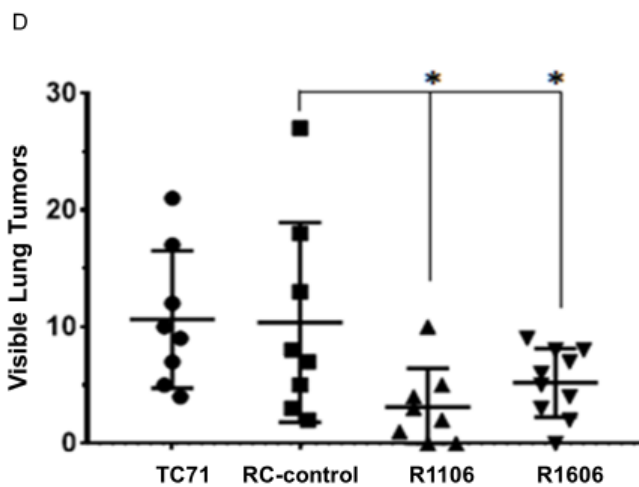
Figure 2. Down ‐ regulation of REST inhibited tumor growth. ( A ) Totals of 5 × 10 5 TC71 parental, RC ‐ control, R1106, or R1606 cells were injected into the tibias of nude mice (10 mice per group). Tumor size was measured 4 weeks later, and the average tumor volume was calculated. One ‐ way analysis of variance (ANOVA) showed a significant difference in tumor volume among groups ( p = 0.001) or between groups (* p < 0.05). ( B ) Immunofluorescence staining for REST expression in the different tumor tissues confirmed that REST was down ‐ regulated in the R1106 and R1606 tumor samples. Scale bar: 50 μ m. ( C ) The Ki67 cell proliferation marker was used to assess cell proliferation. Ki67 expression was quantified in the different tumor samples by PCI software. Ki67 expression was not significantly different in the R1106 and R1606 tumor tissues compared with the RC ‐ control tumors. ( D ) Leg amputations were performed at 4 weeks after tumor cell intra ‐ tibial injection, and mice were maintained until 15 weeks after injection, when mice were killed, lungs were harvested, and visible lung tumor nodules were recorded. One ‐ way ANOVA analysis of variance showed a significant difference in lung metastasis among groups ( p = 0.0197) or between groups (* p < 0.05).